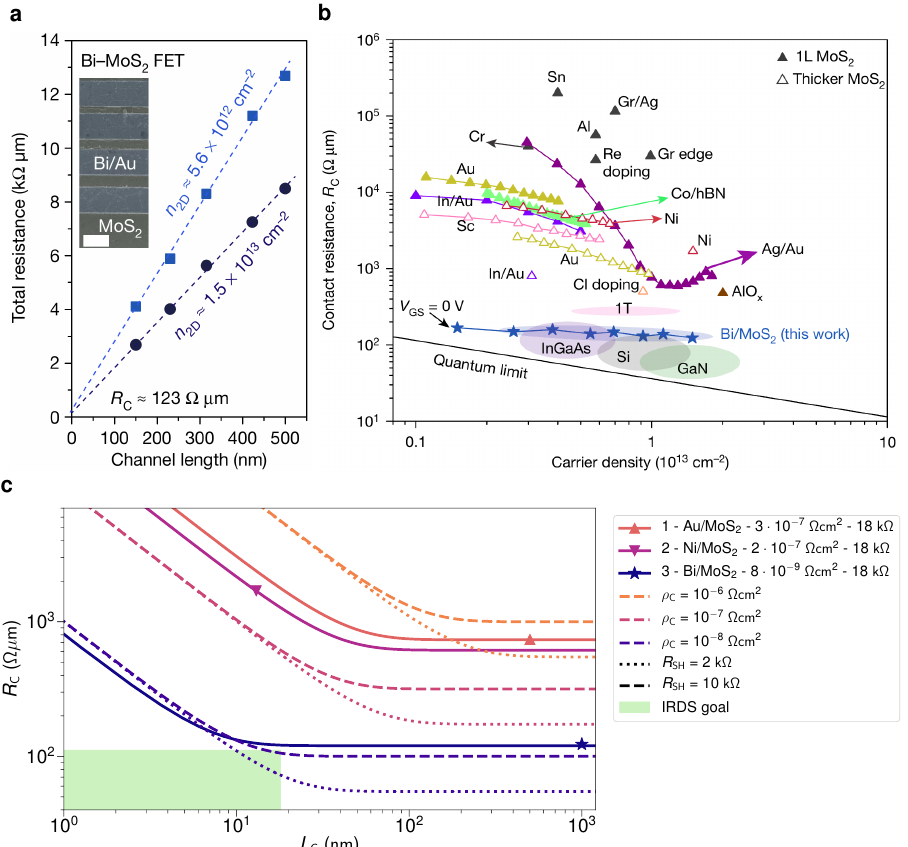
Figure 3. ( a ) Transfer length measurements (TLM) for Bi contacts to a monolayer of MoS 2 using a 100nm thick SiN x gate insulator. The total resistance is measured for different channel lengths at different gate overdrive voltages, corresponding to different carrier densities, n 2D . The intercepts of the linear regression through the measured resistances with the y-axis at L = 0nm determine the contact resistance of 123 Ω µm. In the inset, a false-color SEM image of the TLM structure is shown (scale bar 1µm). ( b ) Comparison of contact resistances R C reported in the literature for monolayer and multilayer MoS 2 as well as conventional semiconductors InGaAs, Si and GaN as a function of the carrier density n 2D . A solid black line indicates the quantum limit of R C , which is determined by the quantum resistance h /2 q 2 and the number of conducting modes per channel width, which is related to n 2D . ( a , b ) reproduced with permission from P. Shen et al., Nature 593, 211–217, 2021; published by Springer Nature [27]. ( c ) Calculated R C as a function of the contact length L C for several combinations of the specific resistivity ρ C and the sheet resistance R SH . At the bottom left corner, the green area indicates the targeted regime [4]. In comparison, solid lines show reported values from references 1 [64], 2 [33] and 3 [27]. The Bi contacts to MoS 2 come close to the target, even though